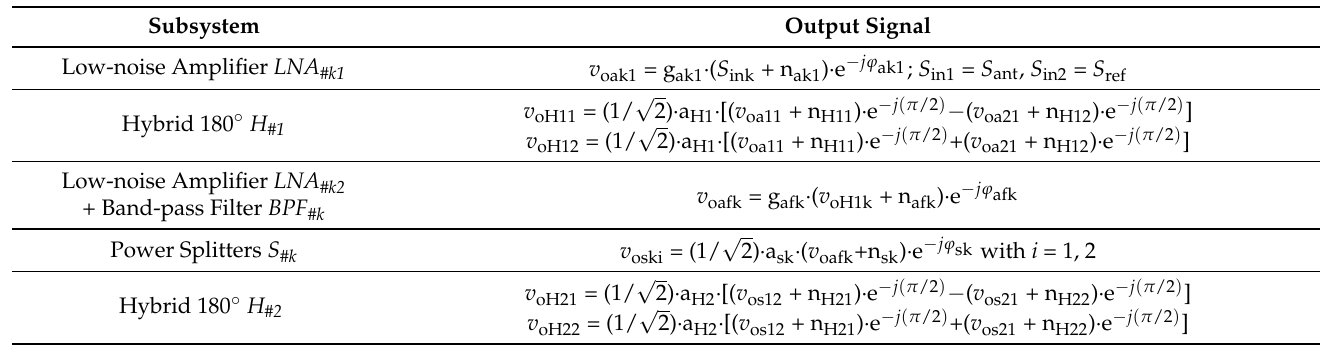
Table 2. The microwave receiver subsystem transfer functions for the proposed configuration, with k = 1 for the upper branch # 1 , and k = 2 for the lower branch # 2 of the schematic in Figure